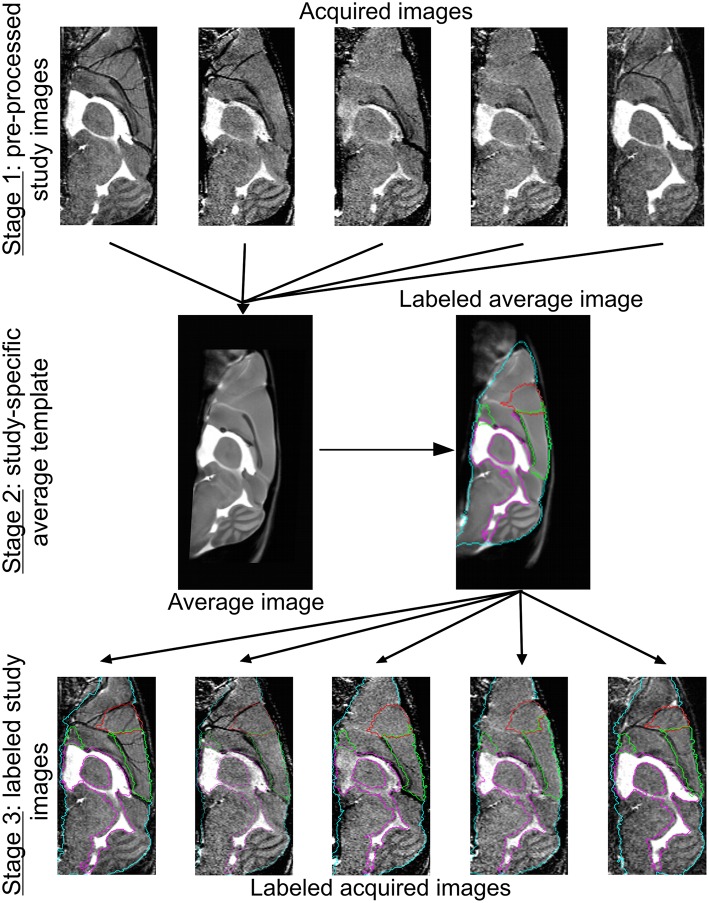
Image registration and labeling. On top, five representative brain MR images are shown. Of all the images from all conditions, we prepared an average study template, which was then registered to the NUS atlas in order to segment the brain into specific brain regions. These brain structures or labels were propagated to the individual images of every animal. The whole brain contour is shown in cyan, the ventricles are delineated in purple, and the frontal and cerebral cortex in red and green, respectively.